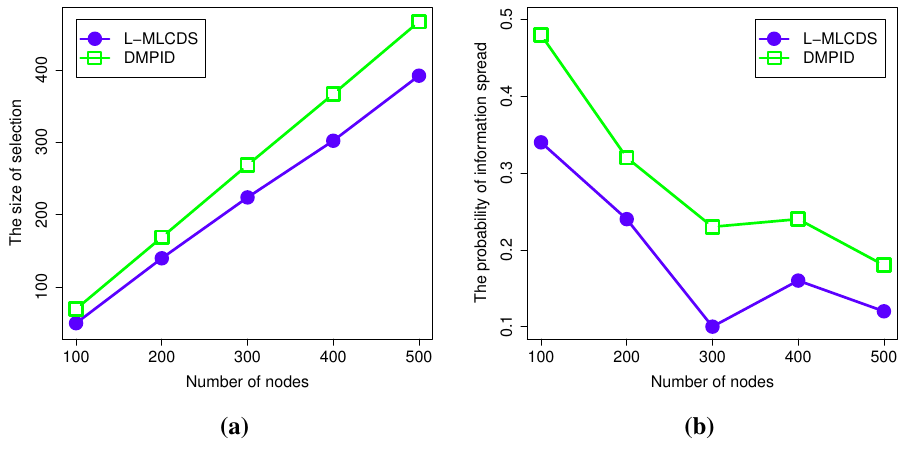
Figure 9. Simulation results for a small world network. ( a ) The size of the selection in small world network; ( b ) The information spread probability in the small world